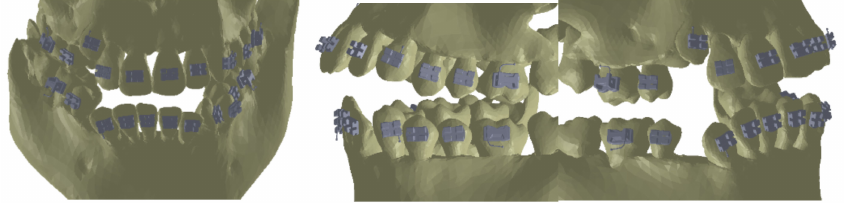
Figure 16. Location of the bracket and tube elements.